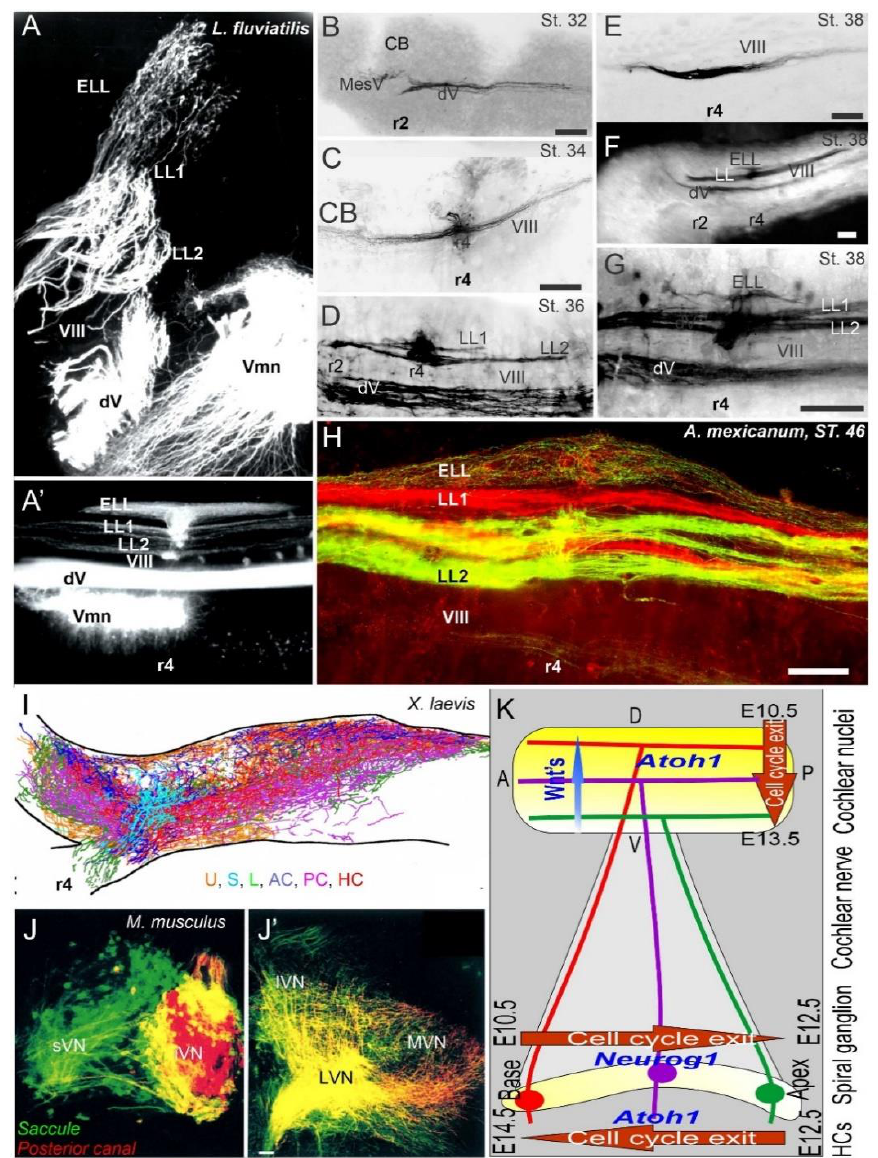
Figure 3. Central projections form afferents to distinct innervation. The lateral line of 2 or more branches form, whereas electroreception receives the short dorsal projection in lampreys ( A , A’ ) and salamanders ( B – H ). Vestibular projection forms after the trigeminal central projection, followed by the lateral line and electroreception ( B – H ). Central projection in a frog ( I ) and mammal ( J , J’ ) show